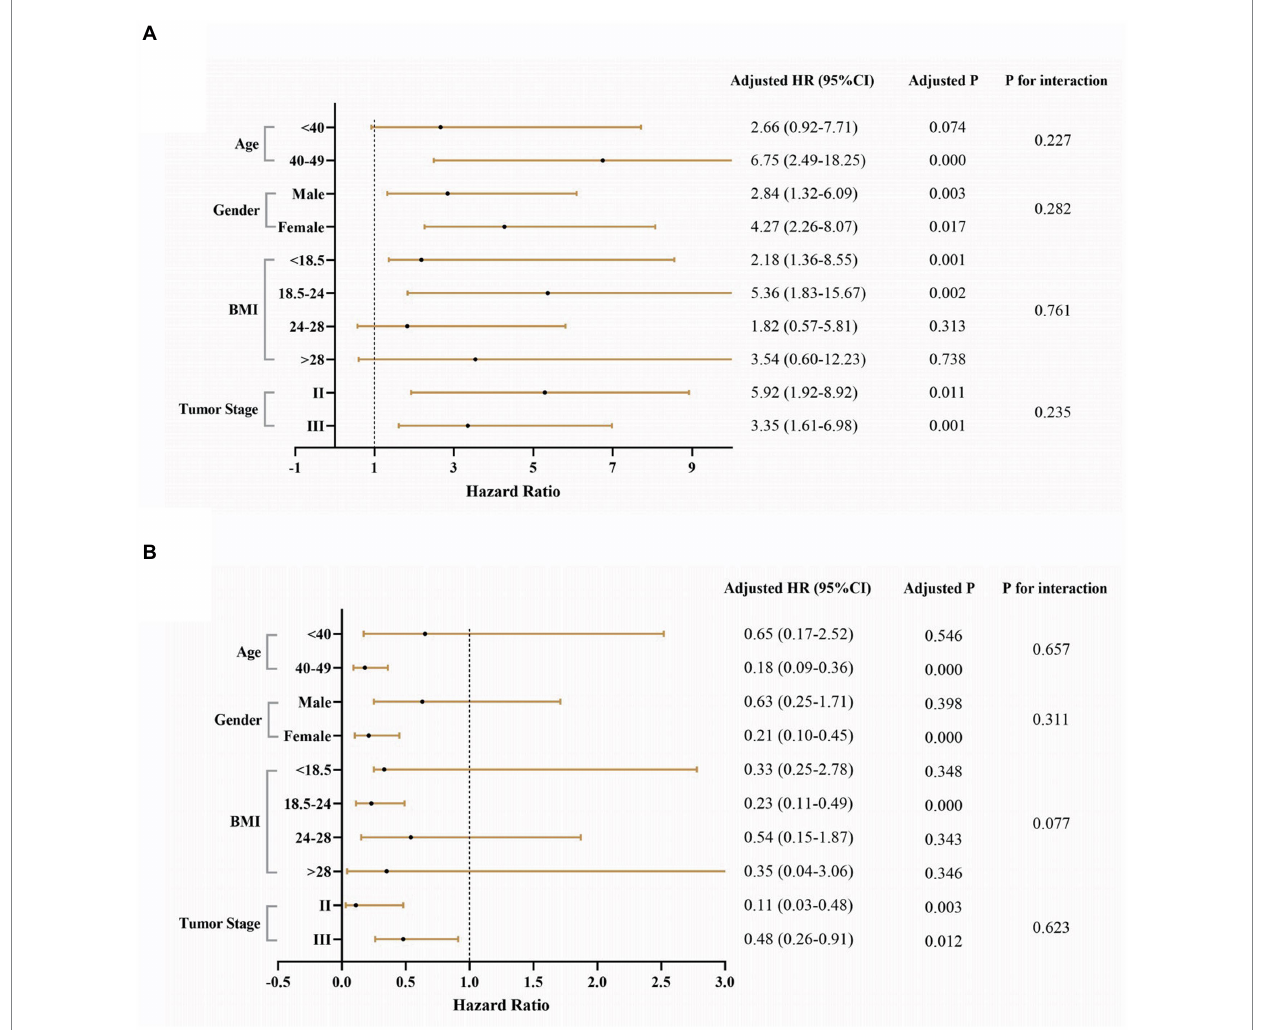
FIGURE 5 Stratification analysis of SII and GNRI in EOCRC. (A) High SII and low SII and (B) High GNRI and low GNRI. Adjusted for age, gender, BMI, tumor stage, smoking, alcohol, tumor location, differentiated degree, nerve invasion, intravascular tumor emboli, preoperative therapy, and postoperative therapy. Because the number of outcome events (deaths) in the stage I group was zero, we did not analyze this